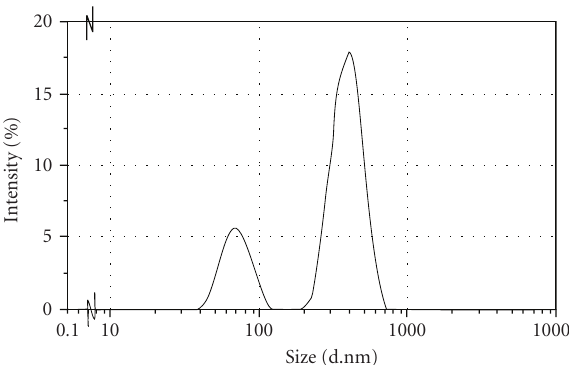
Figure 8: Size distribution of nanochitosan (CHT3N).